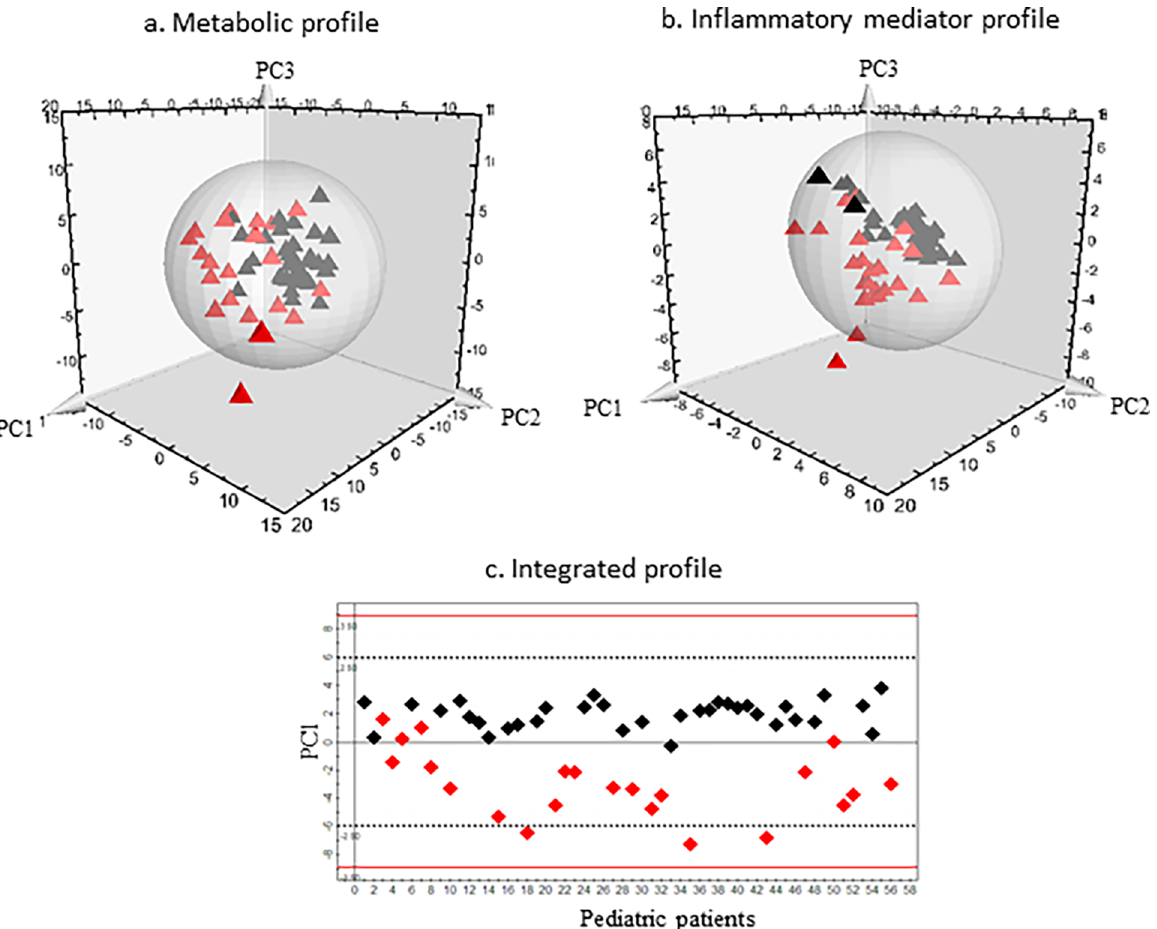
Fig 1. Three-dimensional PCA-X score scatter plots of pediatric patients with and without appendicitis using (a) metabolic profile and (b) inflammatory mediator profile and ( c ) integrated metabolic and inflammatory mediator profile, based on three principle components- PC1, PC2 and PC3. Red tetrahedrons represent the pediatric appendicitis patients and black tetrahedrons represent the pediatric control patients.